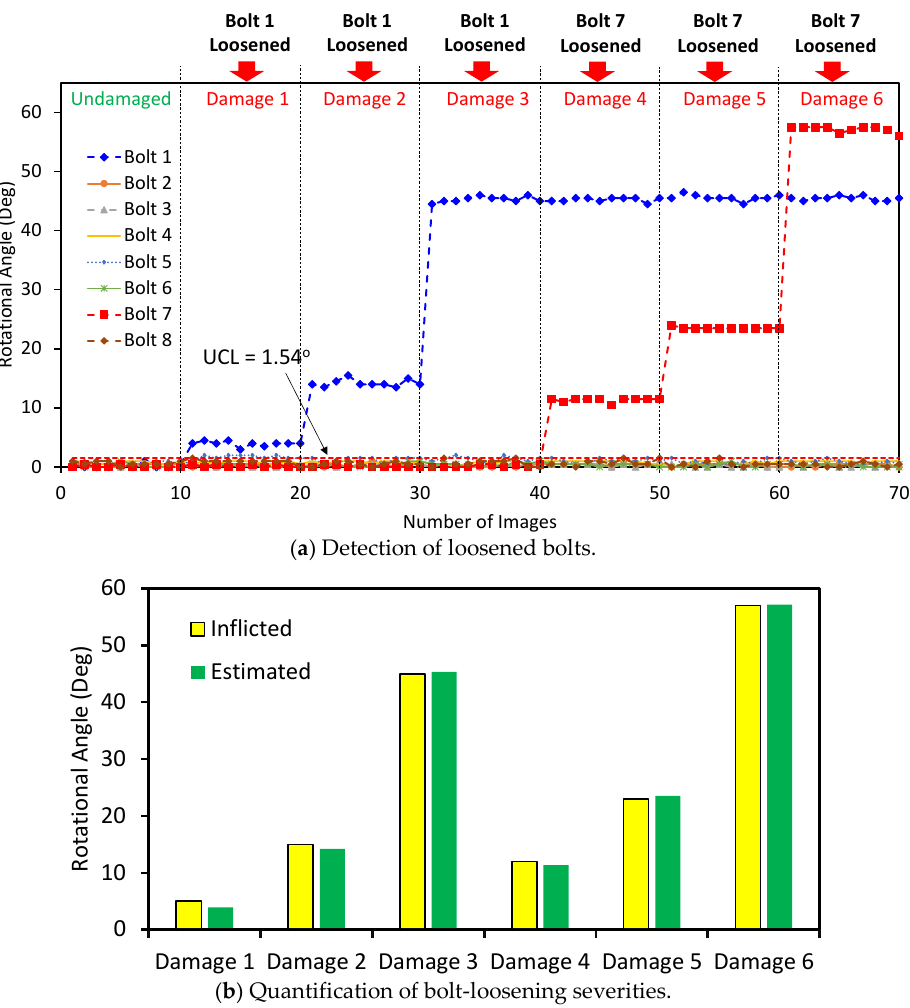
Figure 12. Bolt-loosening detection in the lab-scaled bolted connection model.